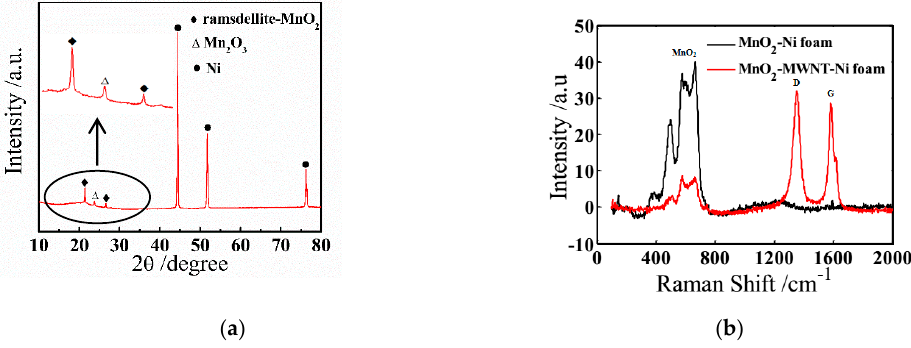
Figure 3. ( a ) XRD patterns of the MnO 2 –MWNT–Ni foam composites. ( b ) Raman spectra of